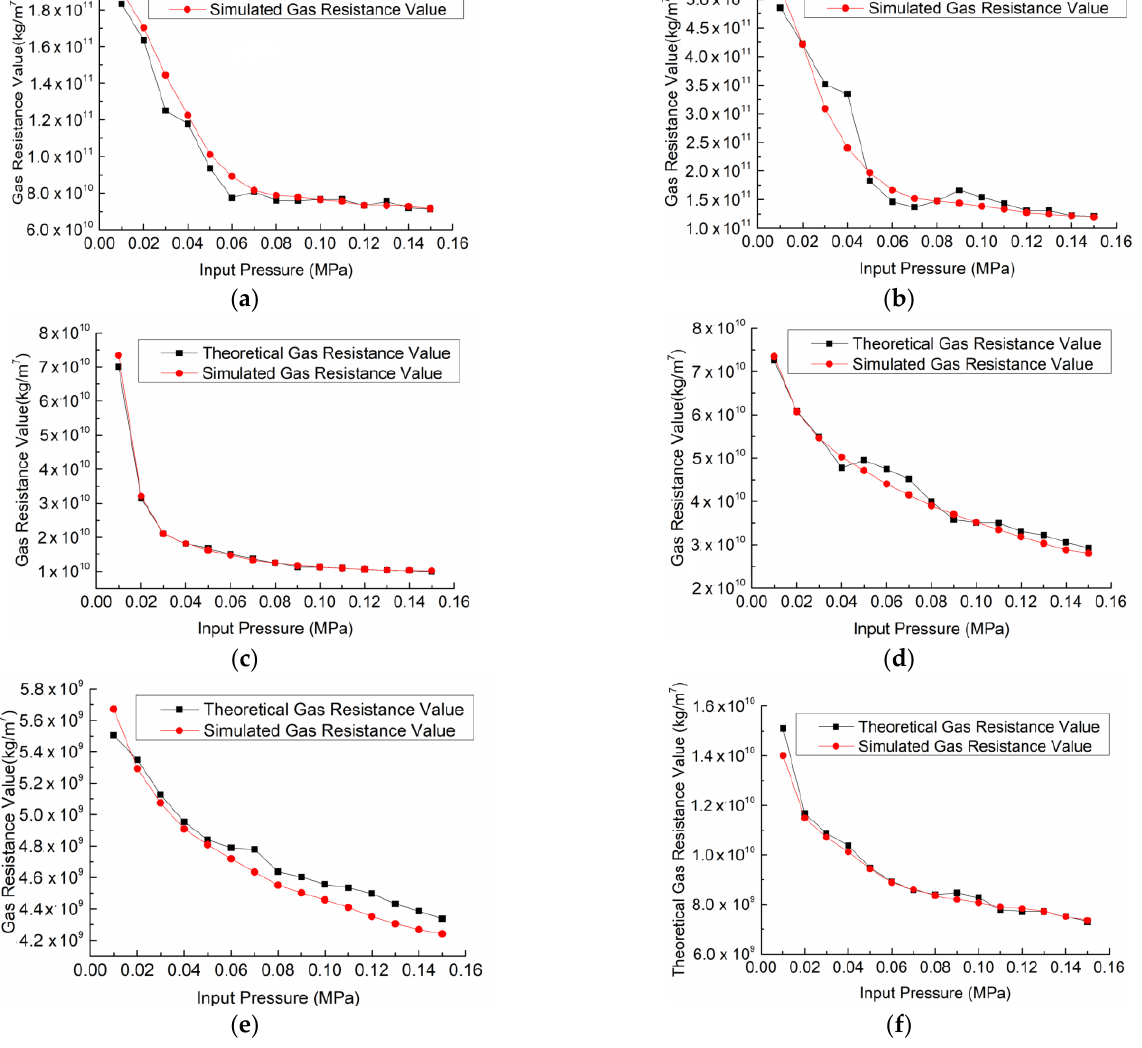
Figure 4. Comparison curve between the simulated and theoretical air resistance values. ( a ) Pipe with 2 mm inner diameter and 0.5 m length. ( b ) Pipe with 2 mm inner diameter and 1.0 m pipe length. ( c ) Pipe with 3 mm inner diameter and 0.5 m pipe length. ( d ) Pipe with 3 mm inner diameter and 1.0 m pipe length. ( e ) Pipe with 4 mm inner diameter and 0.5 m pipe length. ( f ) Pipe with 4 mm inner diameter and 1.0 m pipe length.